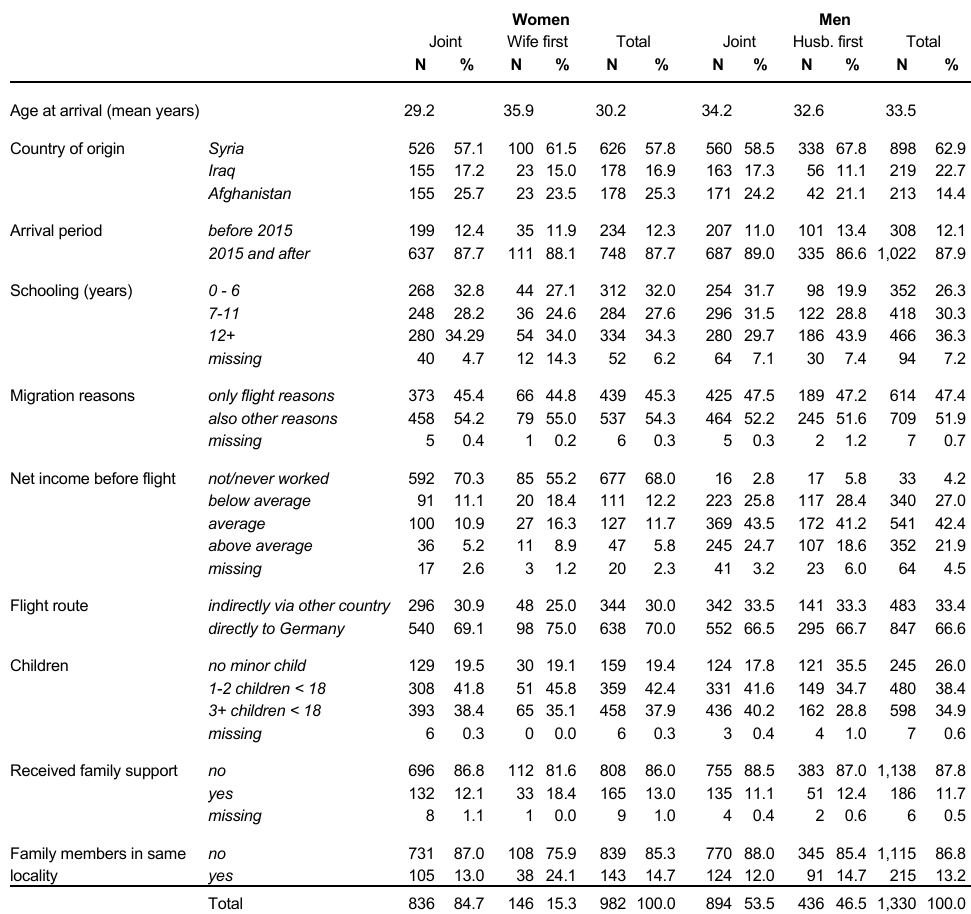
Data : IAB-BAMF-SOEP, wave 1 & 2, 2016-2017 (unweighted N, weighted percentages); due to round- ing percentages may not total